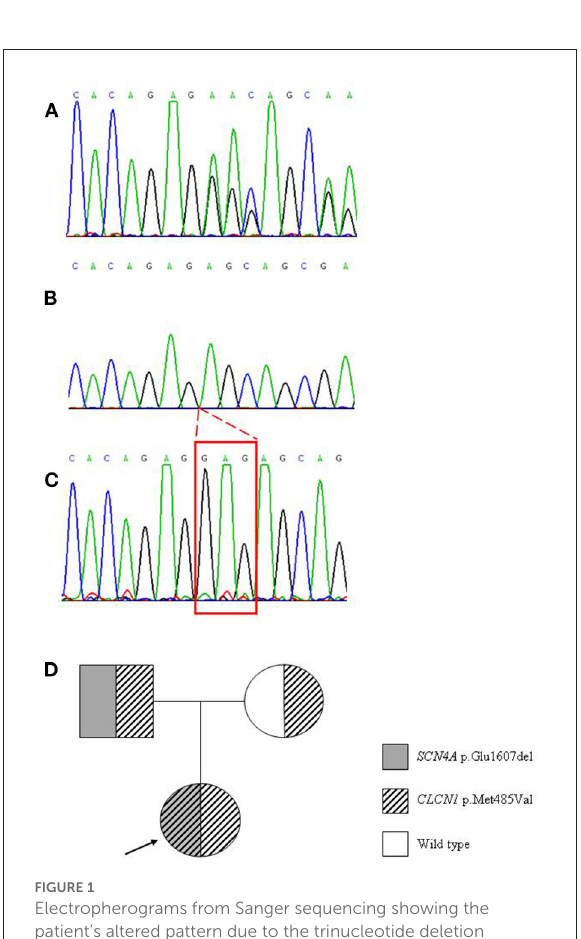
FIGURE1 Electropherograms from Sanger sequencing showing the patient’s altered pattern due to the trinucleotide deletion p.Glu1607del on SCN4A gene (A) electropherogram obtained after cloning of the PCR product carrying the mutation, in order to resolve the mutated from the wild type allele (B) normal pattern in a control case (C) . Genetic tree showing the hereditary pattern of both the mutations harbored by the proband (indicated by the arrow) (D)